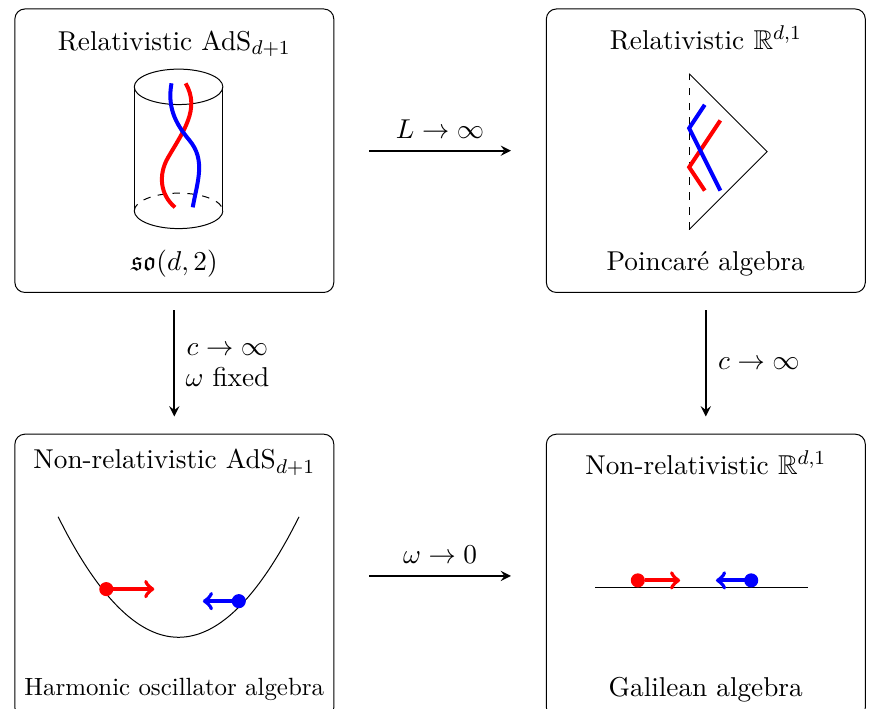
Figure 1 . A sketch of relativistic and non-relativistic physics in AdS and flat spacetime, the symmetries in each case, and the relations between them. The top line represents relativistic physics by the worldlines (red and blue) of a pair of interacting particles moving in AdS (left) and Minkowski (right) spacetimes, which are related by the flat spacetime limit of large AdS length. The bottom right represents Galilean-invariant non-relativistic dynamics. This paper fills in the bottom left corner, namely non-relativistic dynamics with a quadratic Newtonian potential Φ = 1 arising from the c → ∞ limit of AdS. Each arrow represents an İnönü-Wigner contraction relating the respective symmetry algebras. In particular, the arrow marked ω → 0 is the non-relativistic flat spacetime limit discussed in section